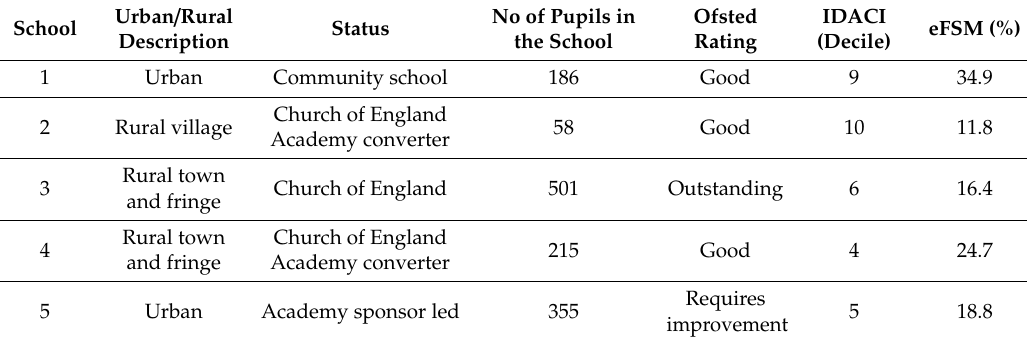
Table 2. Summary of school